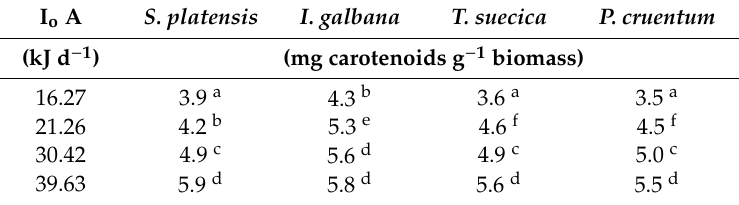
Table 8. Carotenoids content of the four microalgae analyzed in continuous culture at di ff erent supplied light intensities. I o A